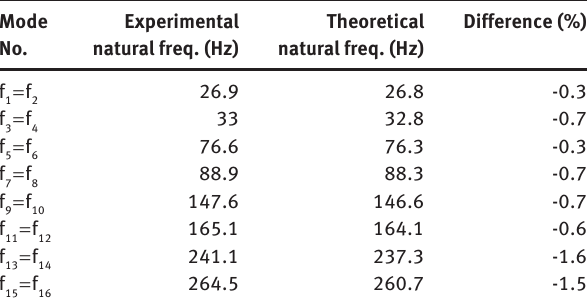
Table 8: Comparison between natural frequencies of truncated cone #1 (experiment and theory).